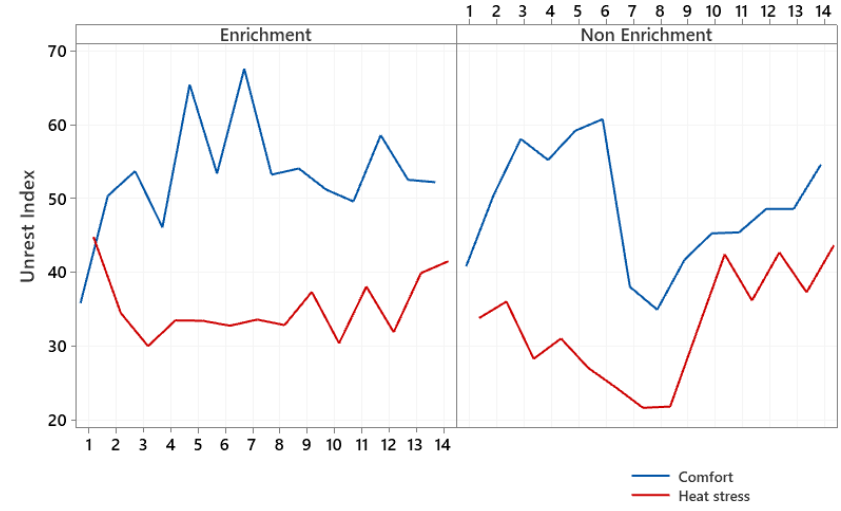
Figure 6. Unrest index of the group of broilers housed in enriched and nonenriched environments under the effect of comfort and heat stress.